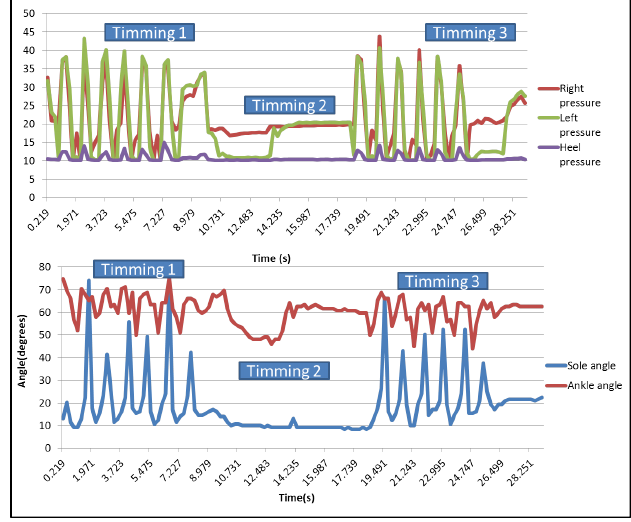
Figure 21. Pressure and bending sensors curve of normal walking.